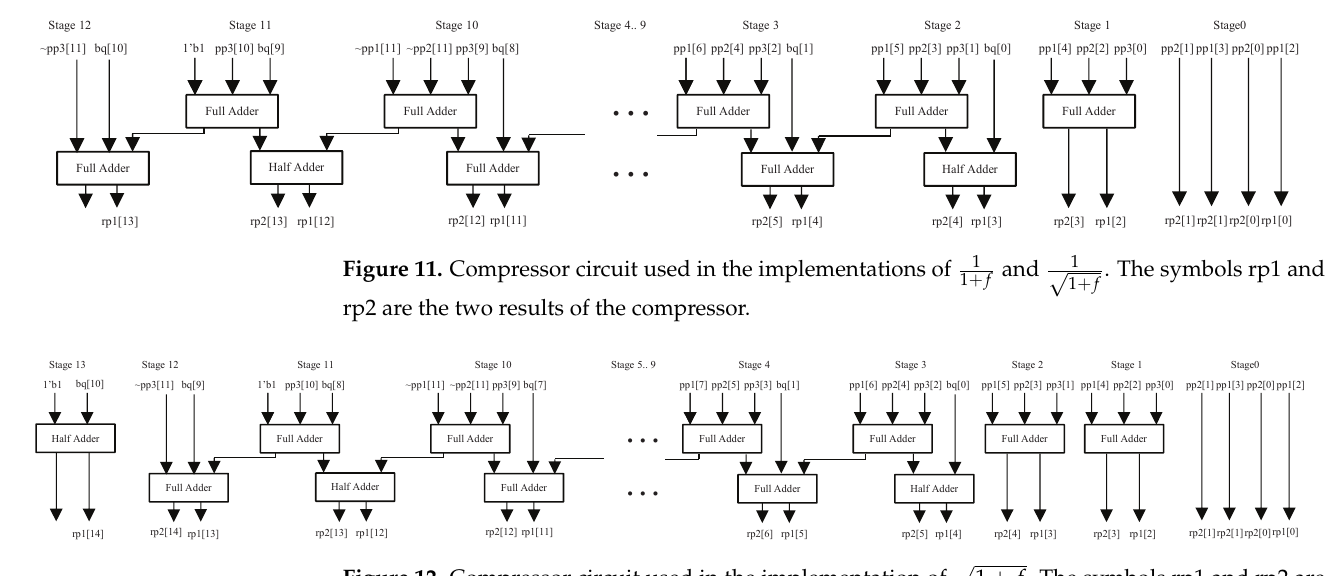
Figure 12. Compressor circuit used in the implementation of the two results of the